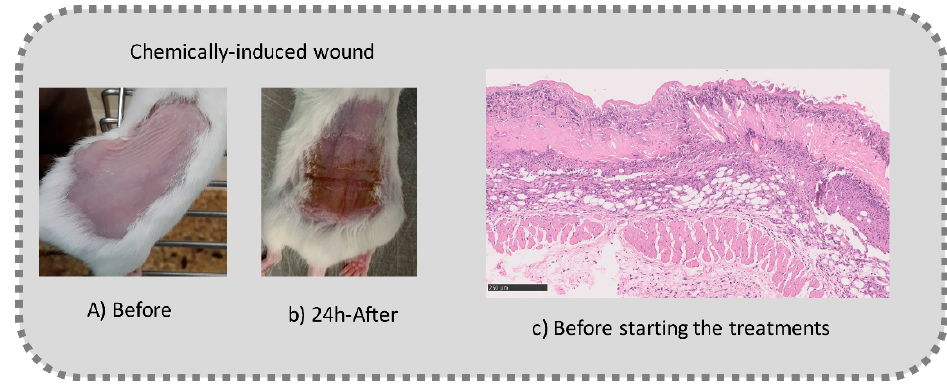
Figure 1. Skin aspect and wound creation: ( A ) Before and ( B ) 24 h-after chemical induction, and (C) histological analysis of skin damage before starting the treatment (magnification of 40 × , scale bar 250 µm).